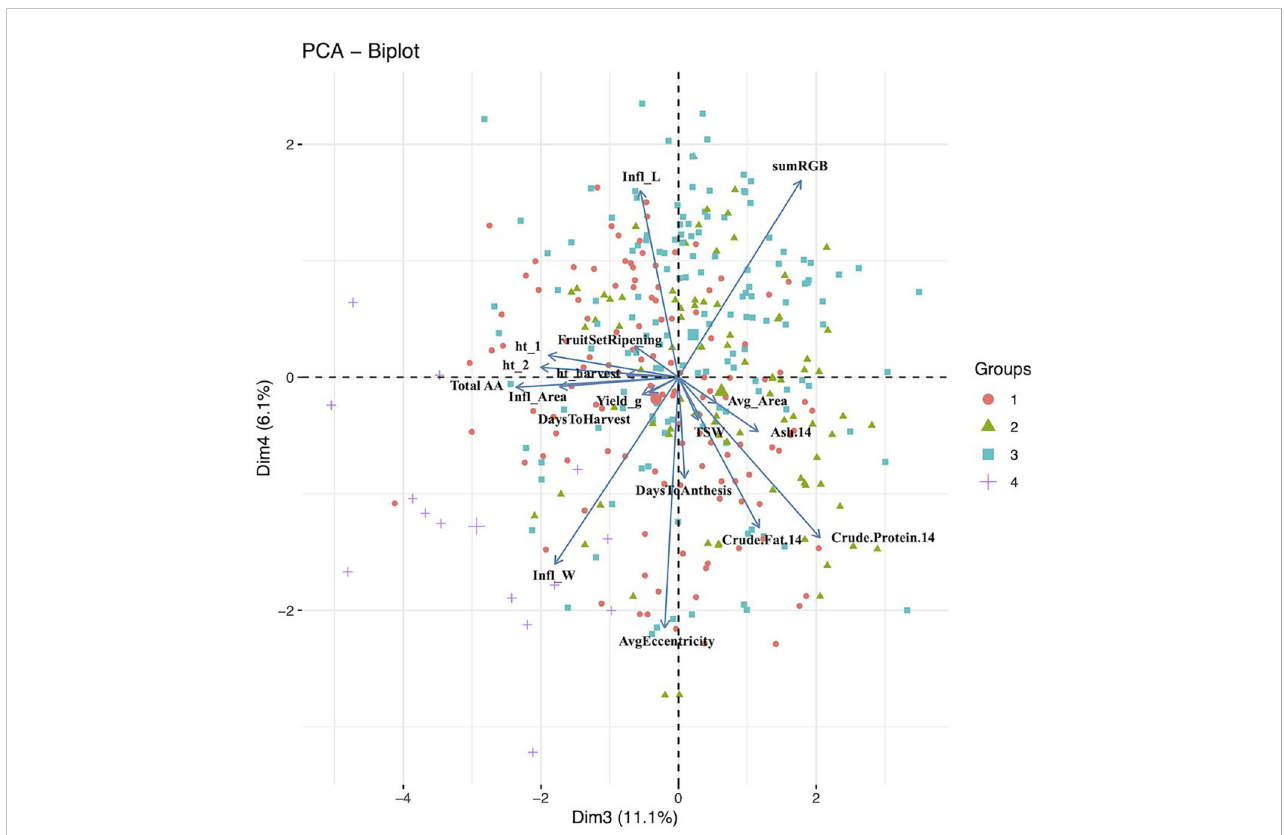
FIGURE 2 Principal component analysis biplot for dimensions 3 (Dim1) and 4 (Dim2). The groups (n =4) are color and shape coded according to agglomerative cluster analysis using Ward ’ s method. The larger shape for each group represent the group centroid. 14, 14% moisture; In fl , in fl orescence; ht_1, height 5 weeks after sowing; ht_2, height 6 weeks after sowing; TSW, thousand seed weight; Avg, average; AA, amino